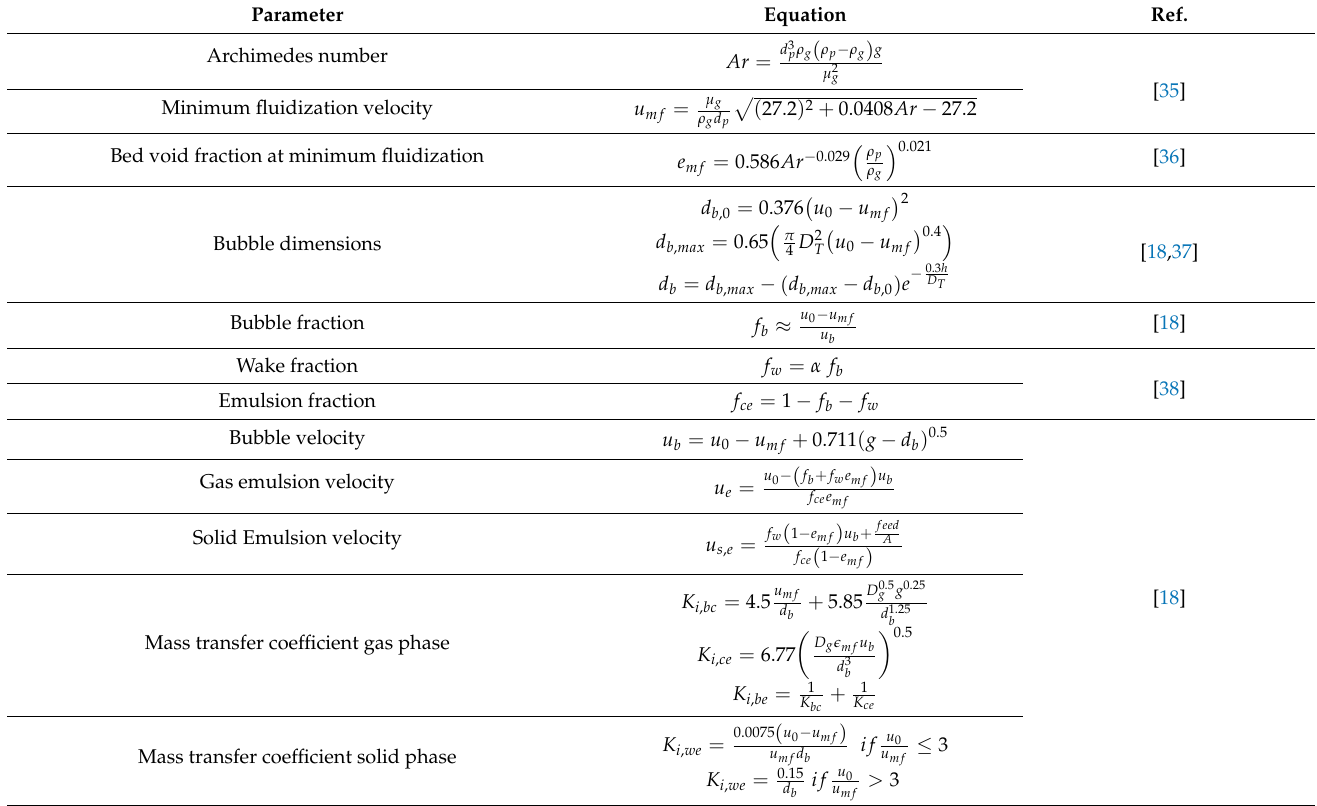
Table A1. Empirical correlations used for hydrodynamics and mass transfer.